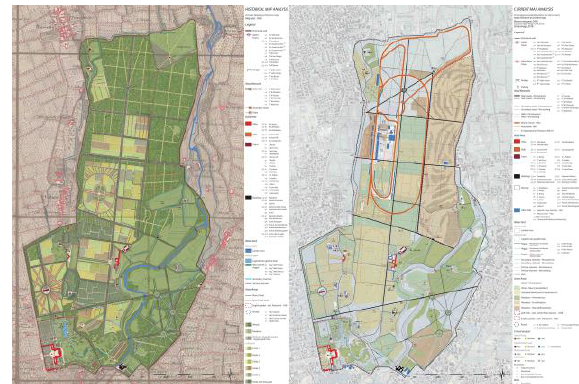
Figure 3. Royal Park of Monza case study: accurate reading and analysis of Brenna’s map (left) and comparison with current situation (right), pointing out the level of decay, transformation, maintenance and functions permanence.